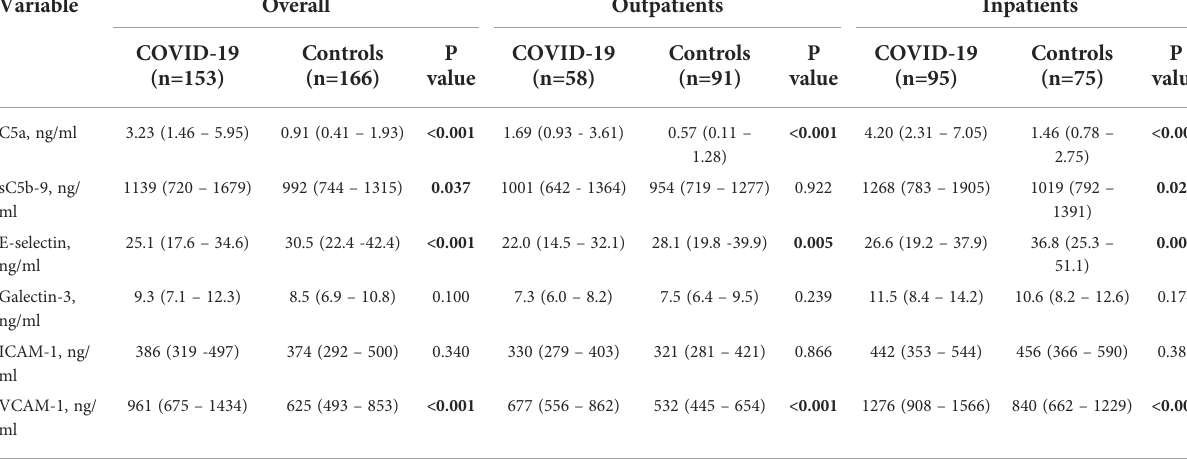
TABLE 2 Concentrations of markers of complement and endothelial cell activation on